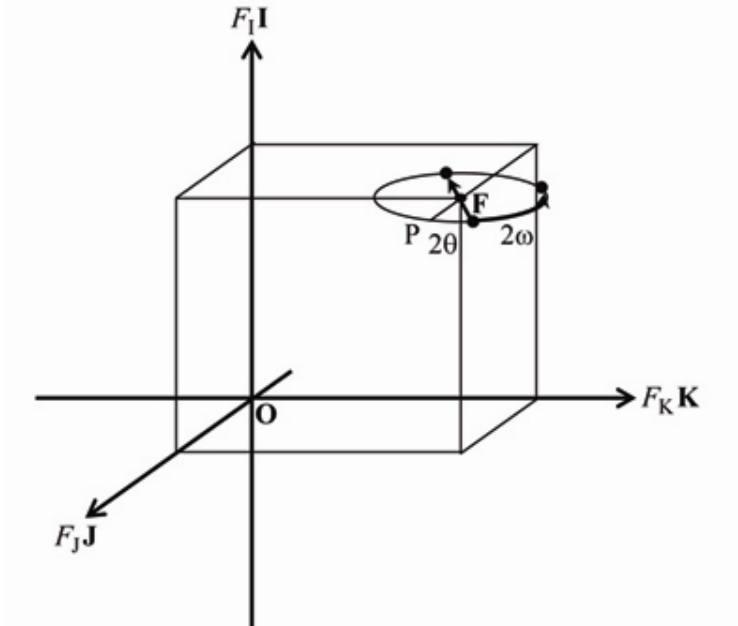
Figure 12 Representation in symmetric dioptric power space of the power of a Jackson cross-cylinder in juxtaposition with a lens of power F . The combination has power represented by the circle; the circle has centre at F and radius equal to the magnitude of the Jackson cross-cylinder and lies in a plane orthogonal to axis I . The Jackson cross-cylinder is initially at angle θ anticlockwise from the primary orientation. Flipping takes the power of the combination diametrically across the circle. Turning through angle ω in physical space takes the power through angle 2 ω in symmetric dioptric power space. The sense of the rotation is the same if viewed down axis I